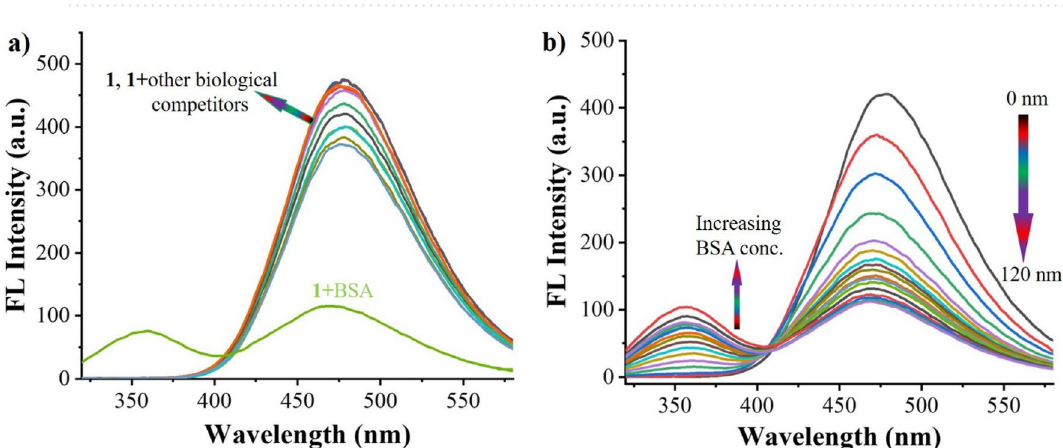
Figure 5. Emission spectra of probe 1 (5 × 10 −5 M) in water with the addition of ( a ) 120 nM of BSA, heparin, ascorbic acid, sodium pyro-phosphate, sodium oxalate, sodium citrate, adenosine triphosphate, glutamic acid, aspartic acid, sodium acetate and glucose ( b ) addition of BSA (0–120